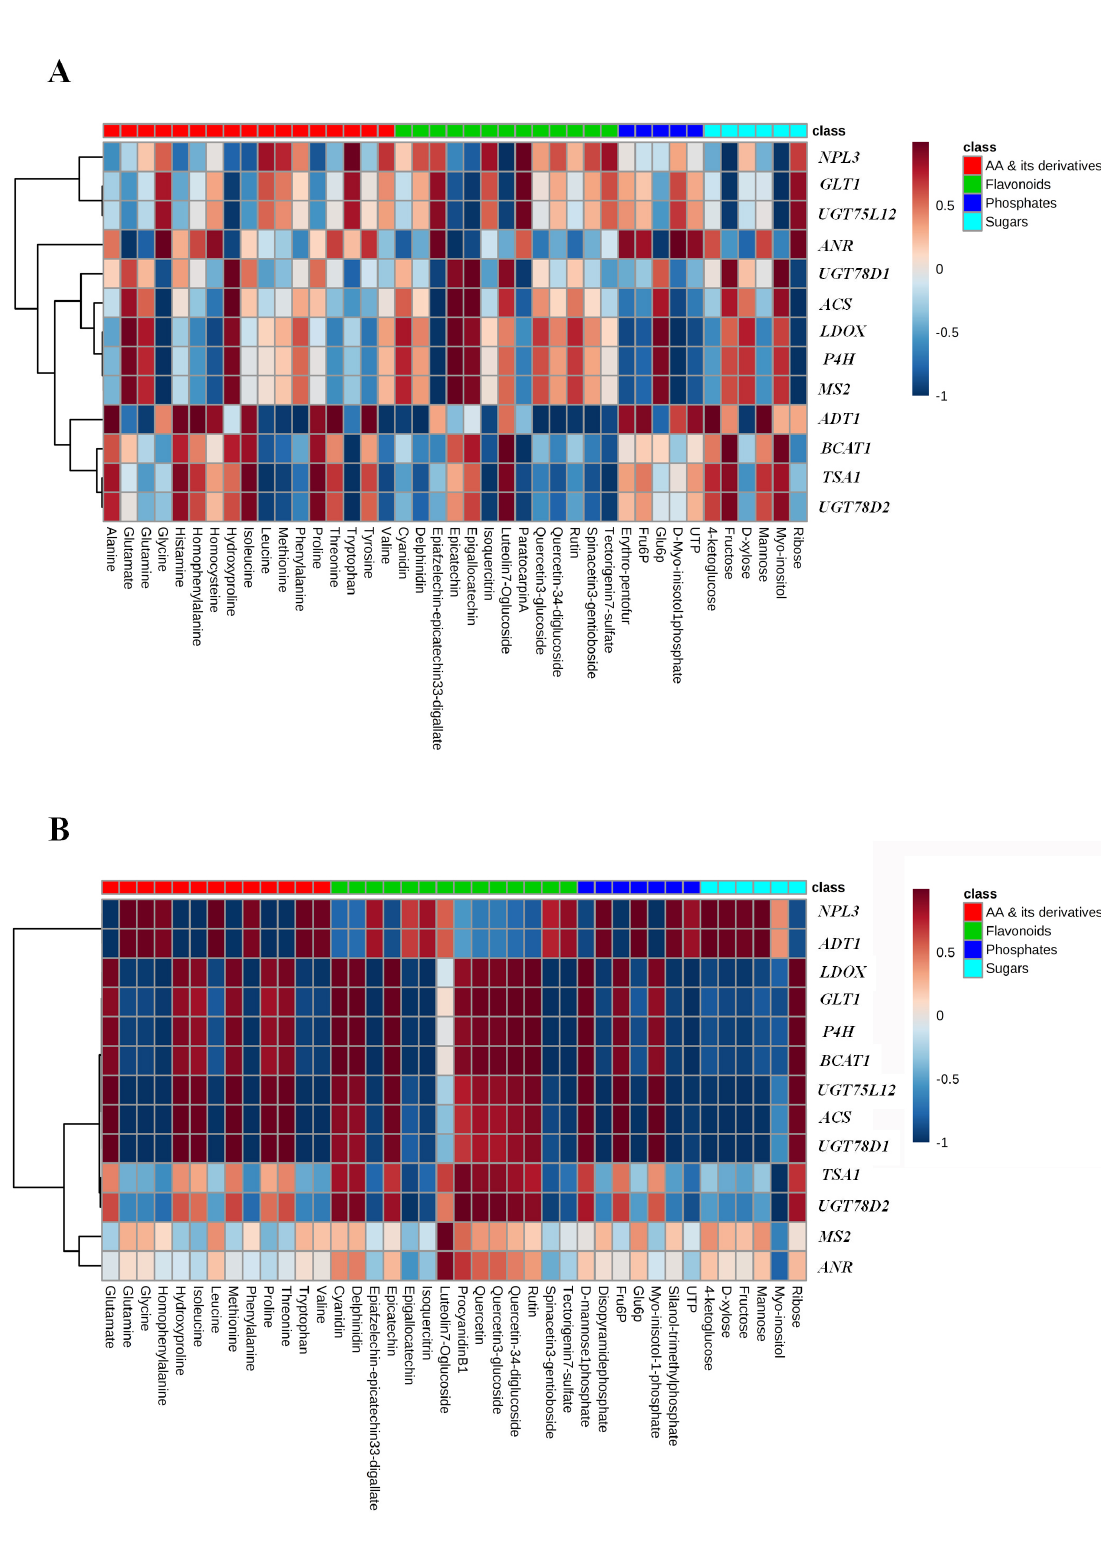
Figure 5. Heat map of correlations between fold change (log 2[ − P/+P] ) of selected significantly changed ( p < 0.05, t -test) metabolites and metabolic genes in young shoots. Red and blue colors indicate positive and negative coefficients and their scales indicate values of Fengqing ( A ) and Longjing-43 ( B